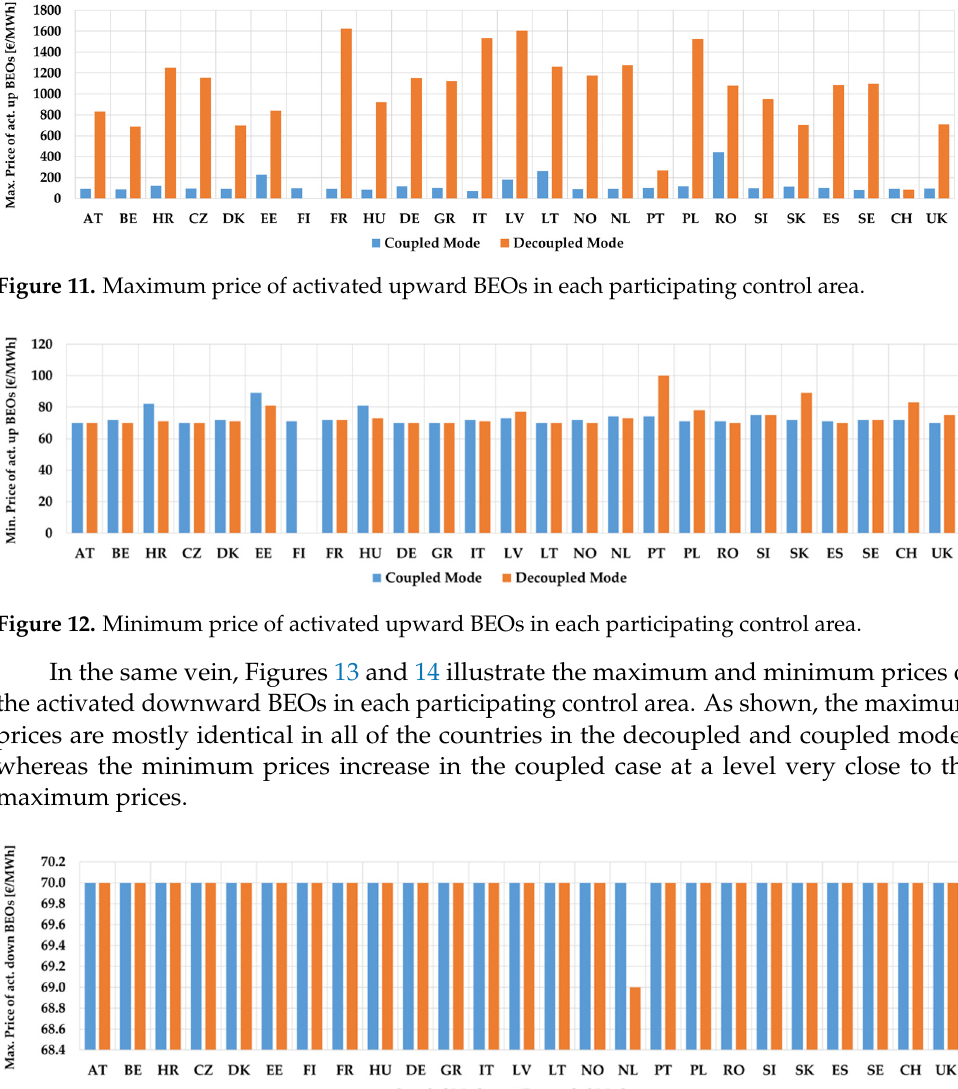
Figure 10. Unitary balancing cost of end-consumers in each participating control area.